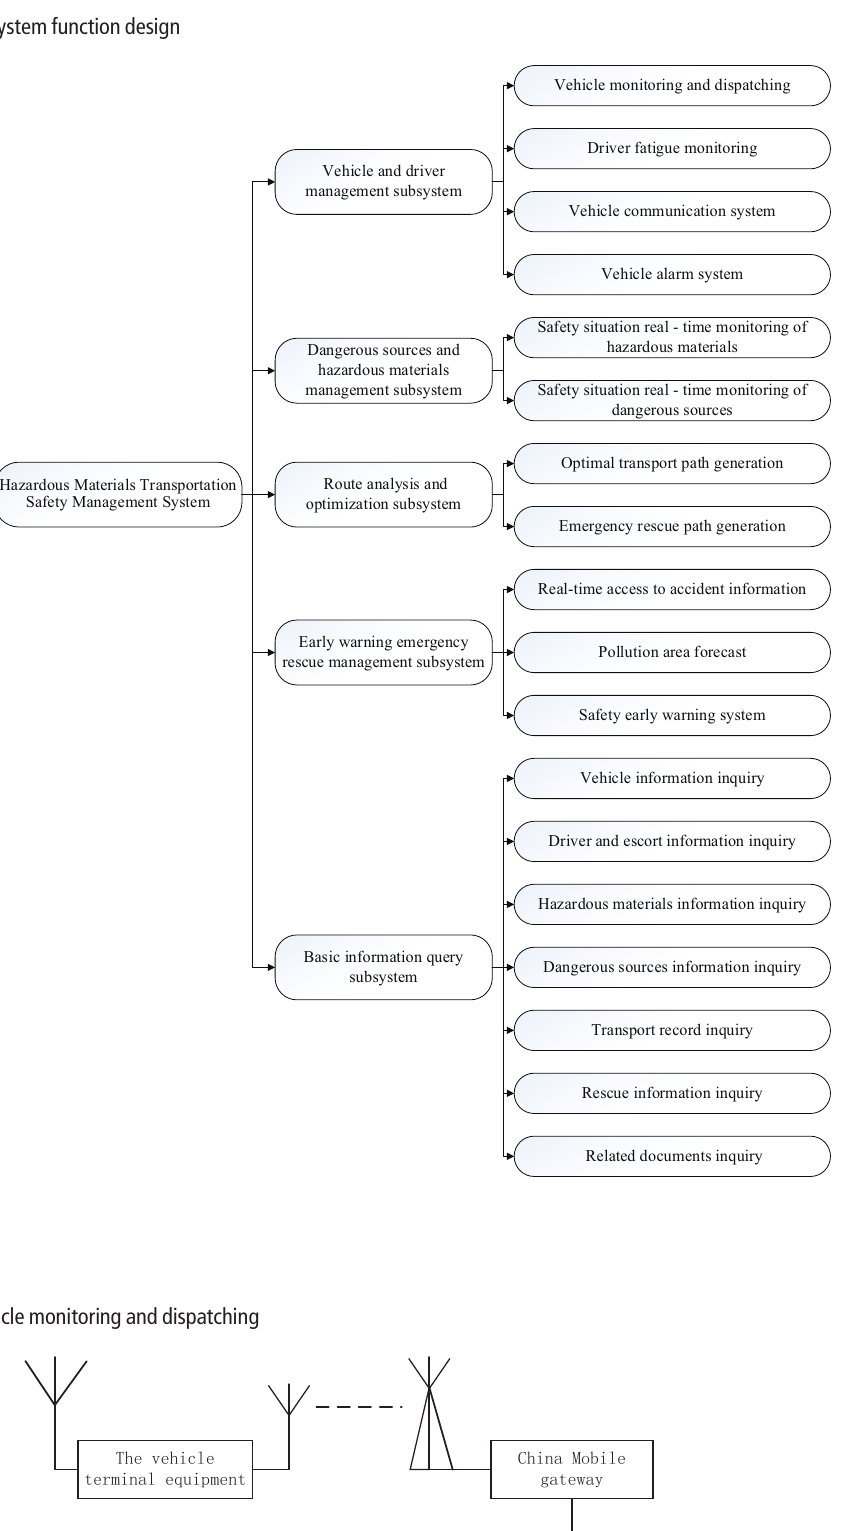
Figure 1 Framework of system function design